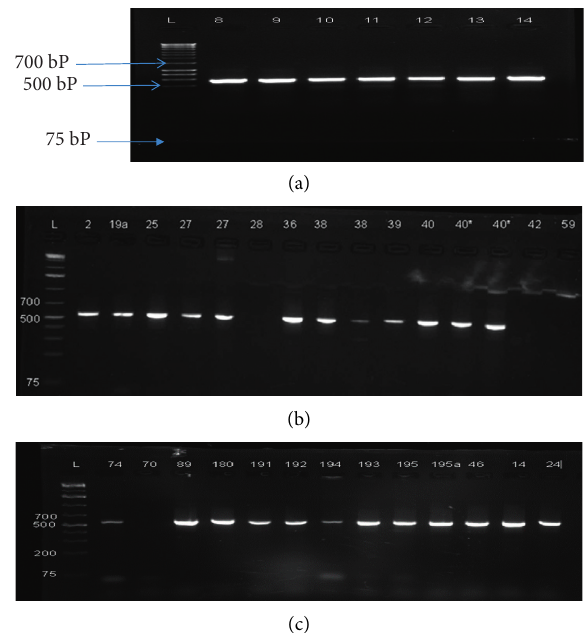
Figure 2: Agarose 1% gels electrophoresis showing PCR products of the DNA for Fusarium spp. isolates obtained with the universal primers ITS1R and ITS4F. (a) Isolates’ Labels: 8- PT8, 9- PT9, 10- PT10, 11- PT11, 12- PT12, 13- PT53 and 14- PT44. The ladder is 1kb. Primers used are: ITS1R and ITS4F. The band for positive result is at 500–550bp. (b) Isolates’ Labels: PT2, PT19, PT25, PT27, PT28, PT36, PT38, PT39 and PT40. Primers used: ITS1 R and ITS4 F. The ladder is 1Kb O Gene-ruler. Expected band is between 500–550 bp. (c) Isolates’ labels: PT74, PT70, PT89, PT180, PT191, PT192, PT194, PT193, PT195, PT195a, PT46, PT14, and PT24. Primers used: ITS1 R and ITS4 F. The ladder is 1Kb O Gene-ruler. Expected band is between 500bp and 550bp.